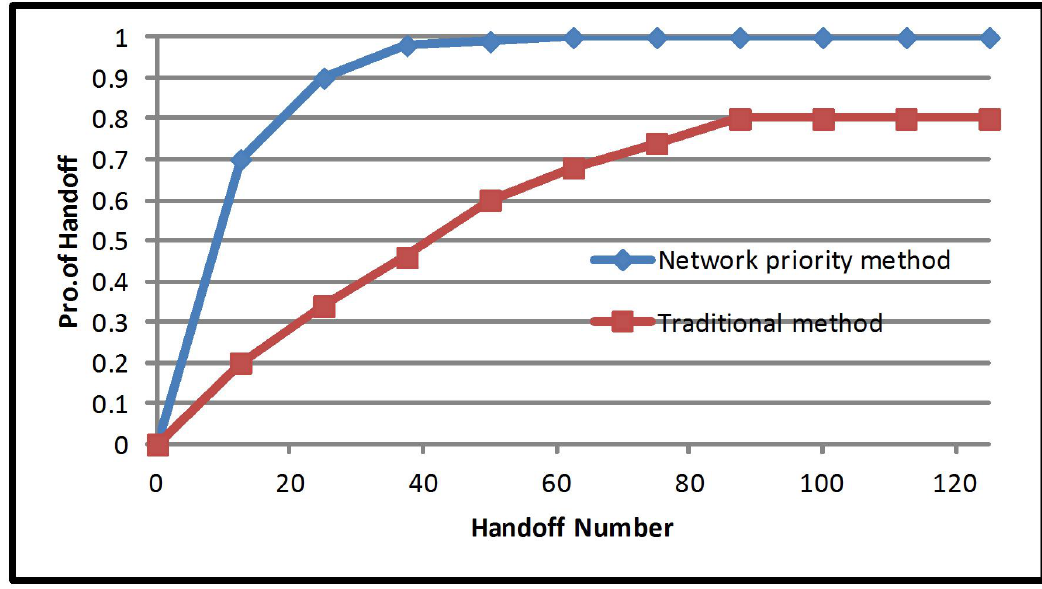
Figure 4. Handoff number probability of the network priority method.